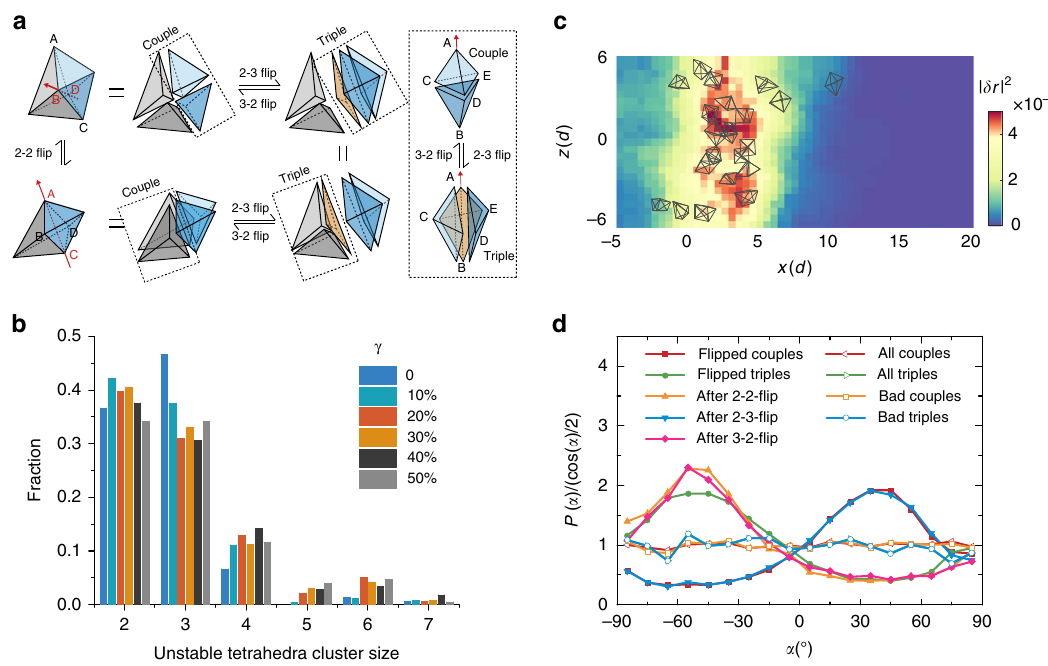
Fig. 2 Properties of fl ip events. a Flip processes for unstable tetrahedra. 2 – 2 fl ip corresponds to a neighbor switching process in which a pair of couples exchange their vertices to form a new pair of couples (BD move closer to become neighbors while AC move away and cease to be neighbors). 2 – 3 (3 – 2) fl ip corresponds to a couple (triple) changing into a triple (couple). 2 – 2 fl ip can also be achieved by consecutive 2 – 3 and 3 – 2 fl ips. The orientation of a couple is de fi ned by the red arrow as the axis direction of two non-coplanar vertices, and the orientation of a triple as the coaxial direction of the coplanar tetrahedra. b Histogram of size of unstable tetrahedral clusters after a single shear step at different γ . Face-adjacent unstable tetrahedra are considered to belong to the same cluster and the number of tetrahedra in the cluster is de fi ned as the cluster size. c Flips in the x – z plane within a 2 d thickness ( (cid:3) 1 d < y < 1 d ) region overlaid with non-af fi ne displacement fi eld at y = 0. The non-af fi ne displacement fi eld has been smoothed over a distance of 2 d . d Probability density distributions of the orientation angles α of unstable couples or triples. α is the angle between the orientation of a couple or a triple and the horizontal plane ( x – y